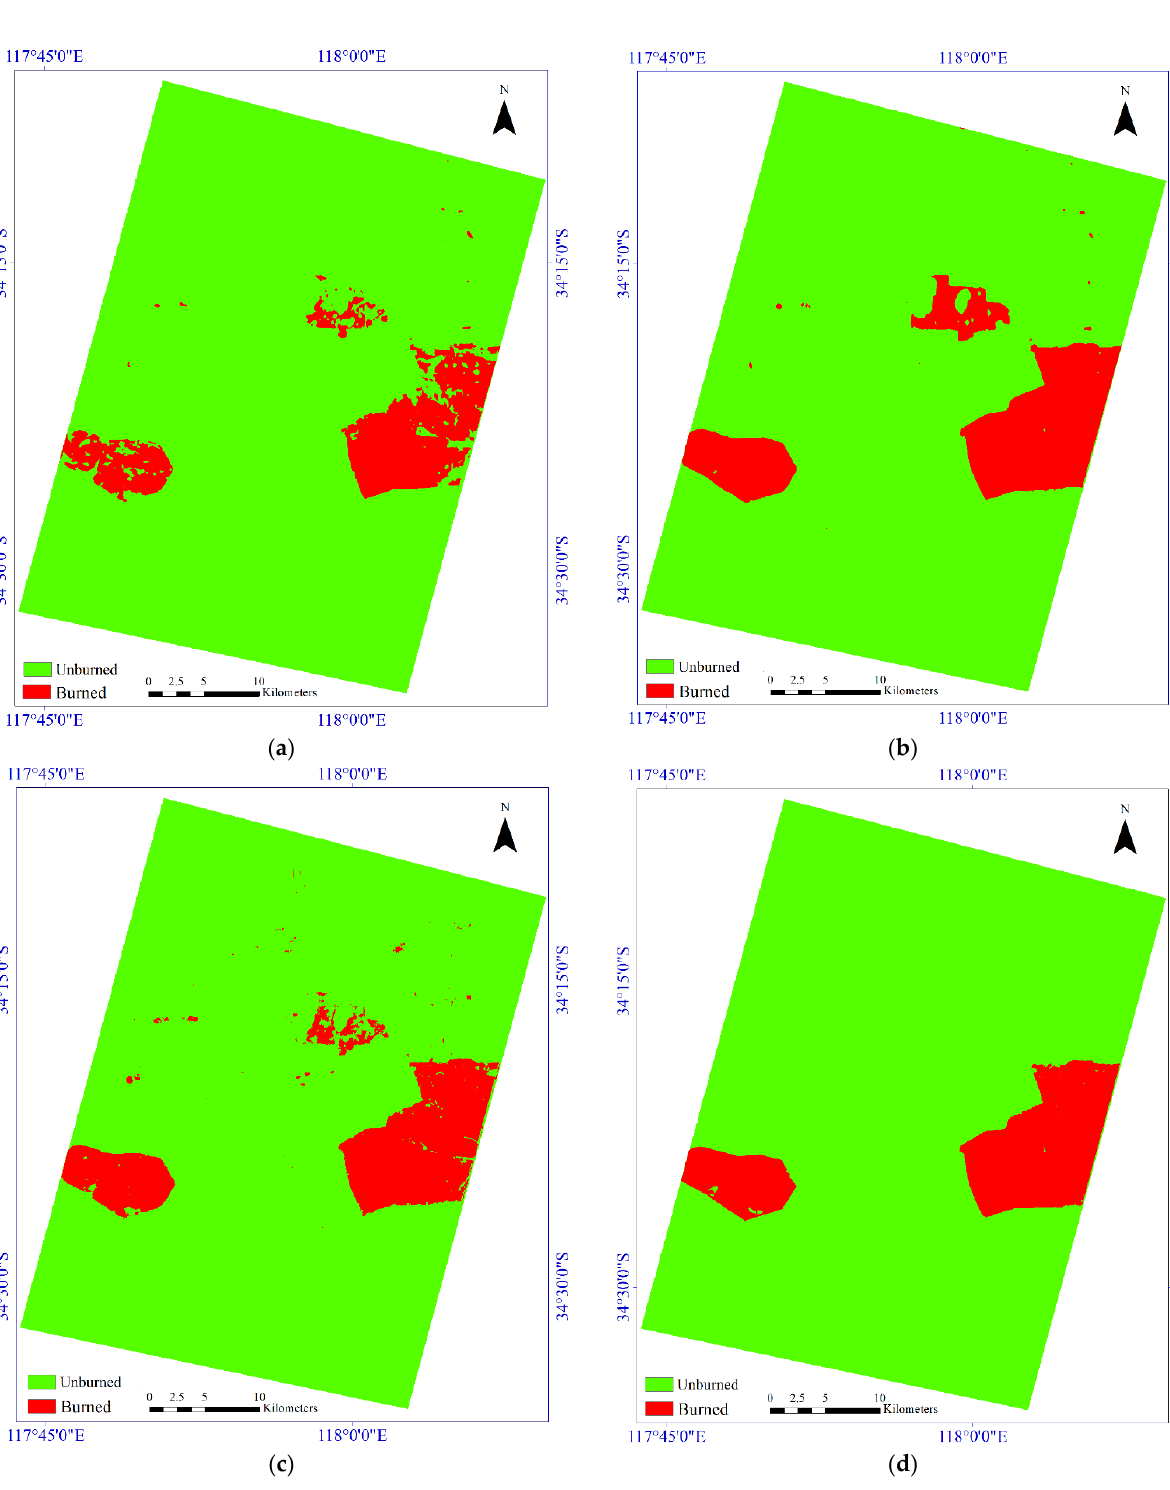
Figure 9. Visual comparisons of the results for the burned area mapping based on the post/pre-event Sentinel-2 imagery for the second study area. ( a ) Deep Siamese network. ( b ) Using the CNN method proposed in [42]. ( c ) Using the method proposed in the present study. ( d ) Ground truth map.